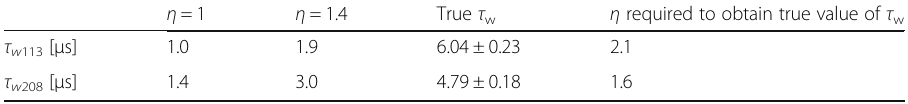
Table 3 Values for τ w obtained with Eq. 5 using values of η available in the literature. Window fractions obtained from detector 2 were used as it covered a larger range of count